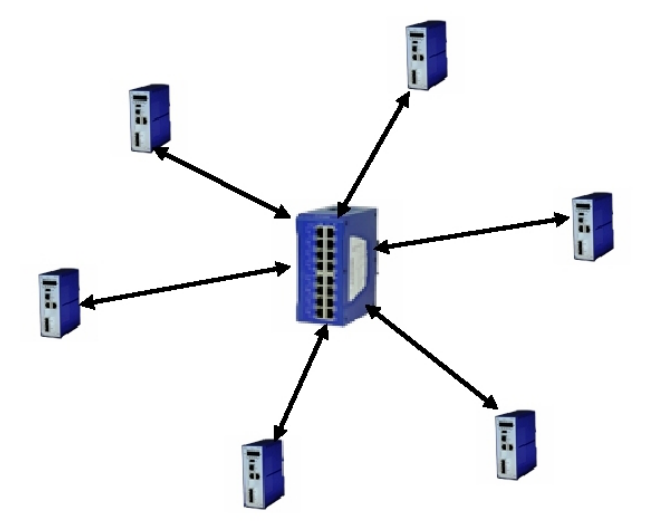
Figure 10. Mesh network topology.